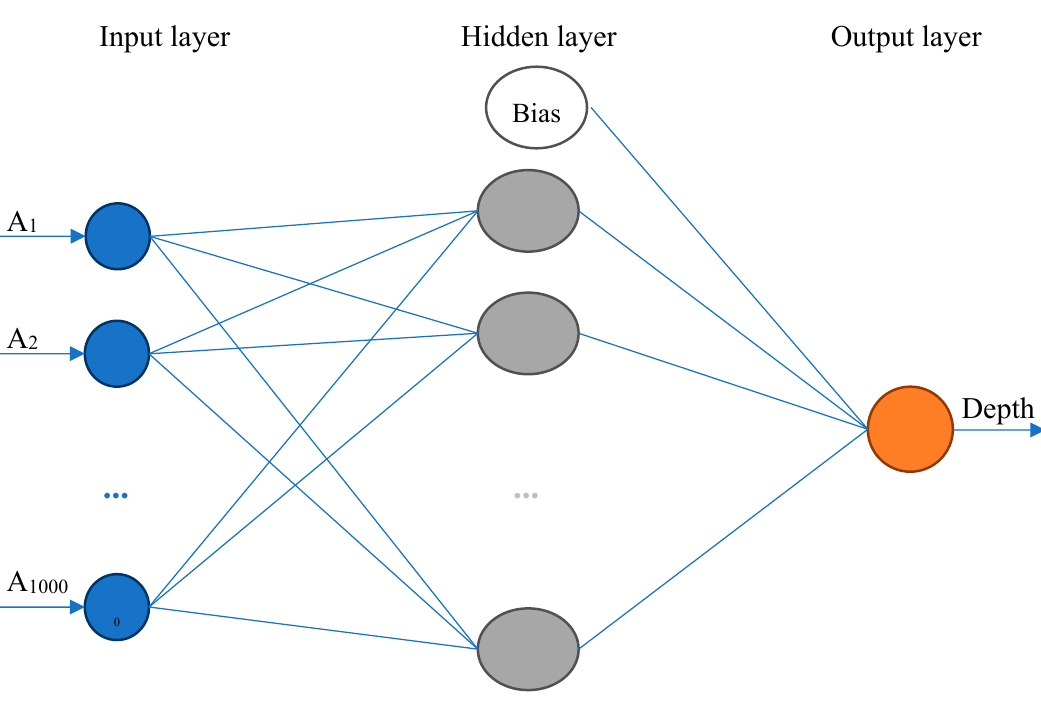
Figure 4. Arrangement of the neural network.